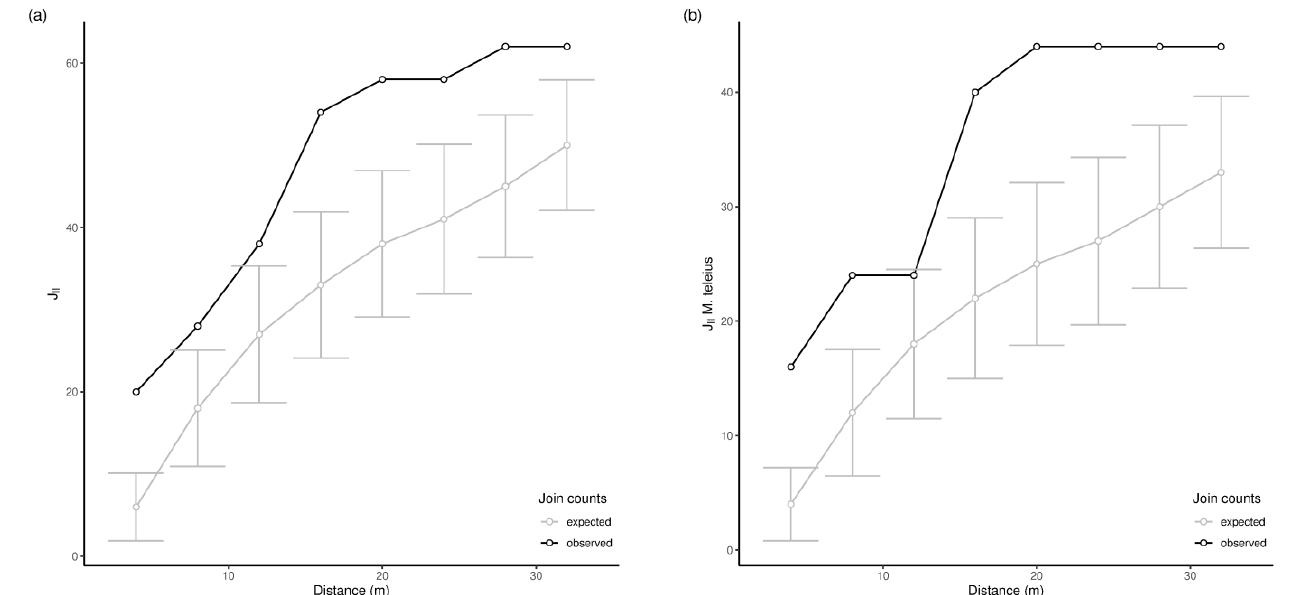
Figure 2. Observed and expected join count values (sum across nests) at different spatial distances (with standard deviation, SD, for expected values) in Kosy´n in spring. The plots show the significance of the aggregation of infected nests by considering all parasites (J II , panel ( a )) or only Ma. teleius (J II Ma. teleius , panel ( b )). For positive spatial association, observed values must be significantly larger than expected.